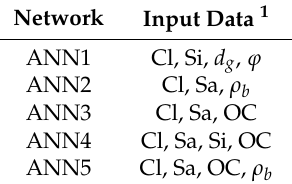
Figure 3. Operating scheme of the generalized feed-forward (GFF) artificial neural network (ANN). Table 2. Combination of inputs in the developed artificial neural networks (ANNs).